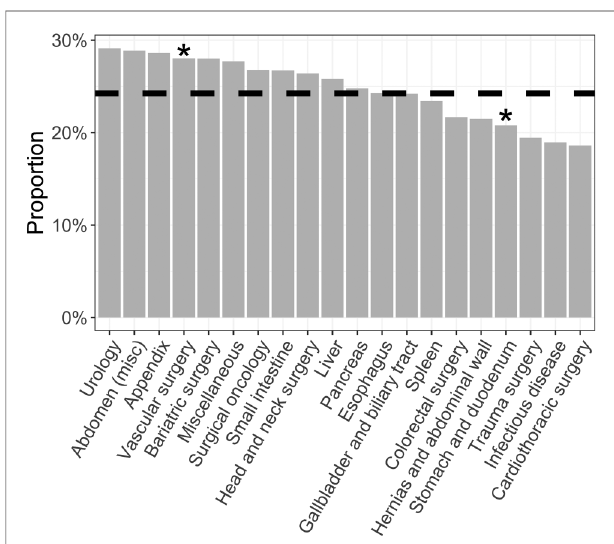
FIGURE 3 | Abstracts submitted by females strati fi ed by topic/subspecialty. The dashed line represents the mean female proportion (24.2%). * p <0.05